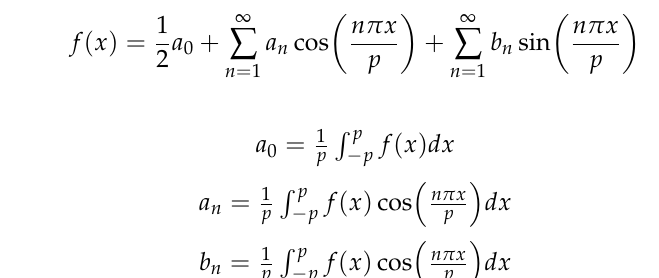
Figure 3. Time series of ( a ) dissolved oxygen (DO), ( b ) turbidity (Tu), ( c ) specific conductivity (K), and ( d ) water temperature (WT) at the outlet of the Difficult Run watershed during the period 2012–2017.